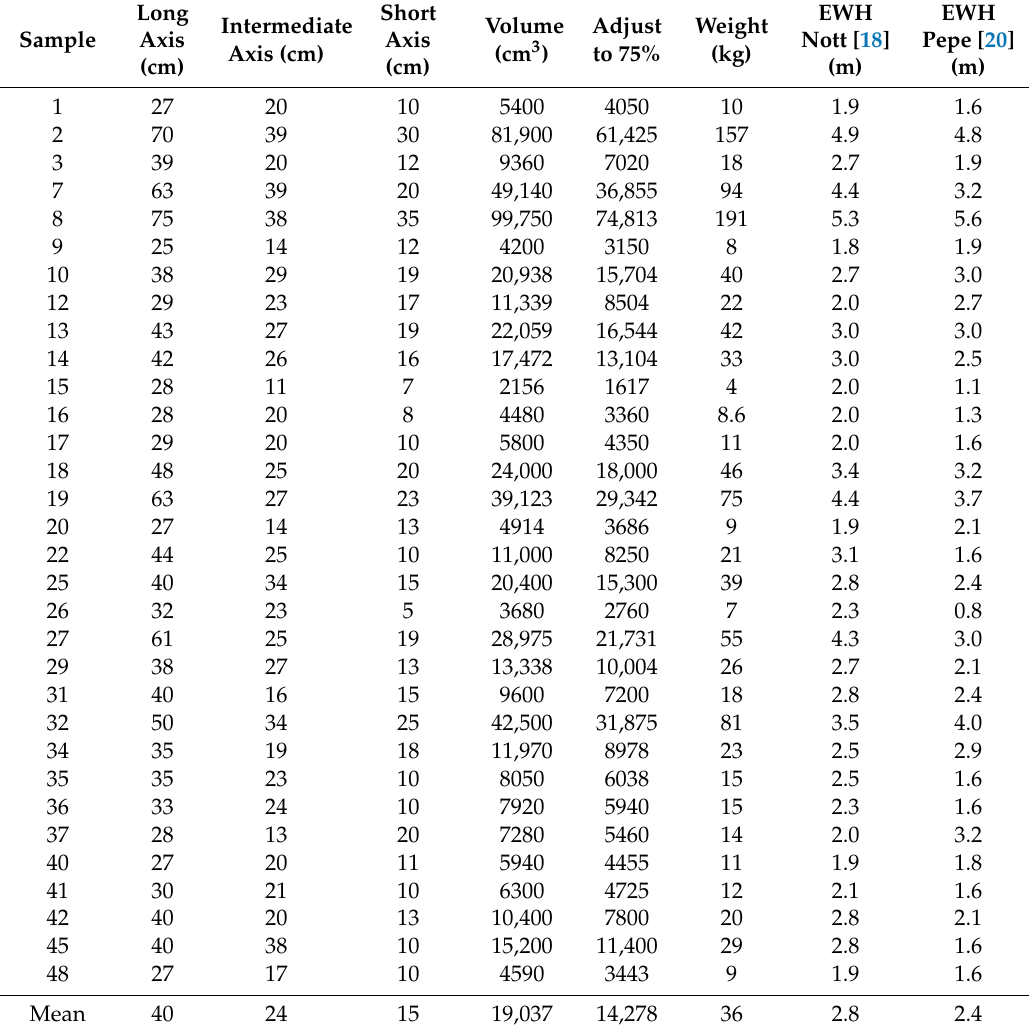
Table A4. Quantification of boulder size, volume, and estimated weight from all coastal bar boulders through transect 4 at Bah í a San Luis Gonzaga. EWH = estimated wave height. The density of Baja Californian andesite at 2.3 gm / cm 2 is applied uniformly in order to calculate wave height for each boulder.